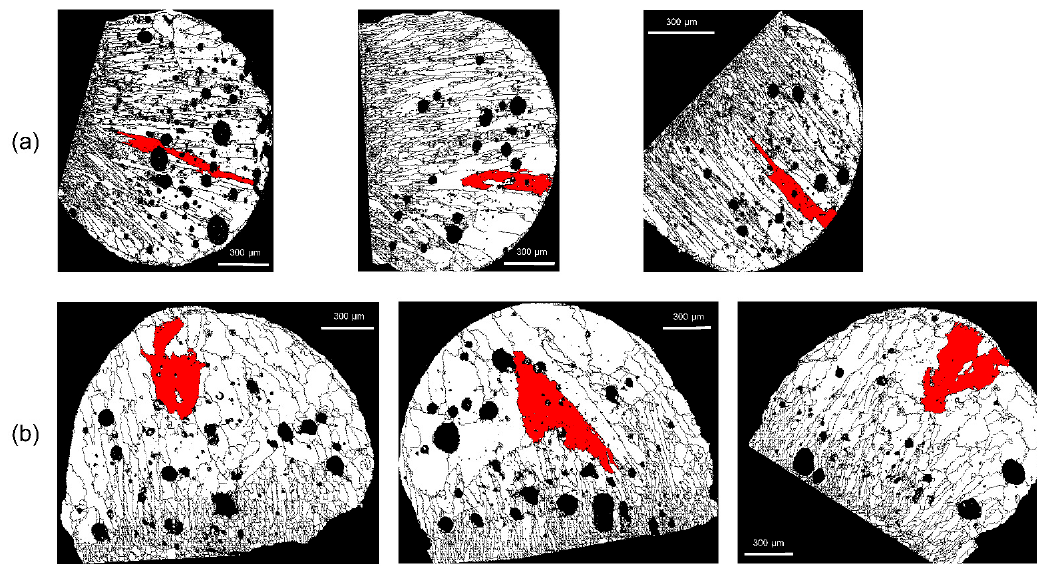
Figure 10. Color representation of the grain with maximum size: ( a ) PAB-25 and ( b ) PAB-600.